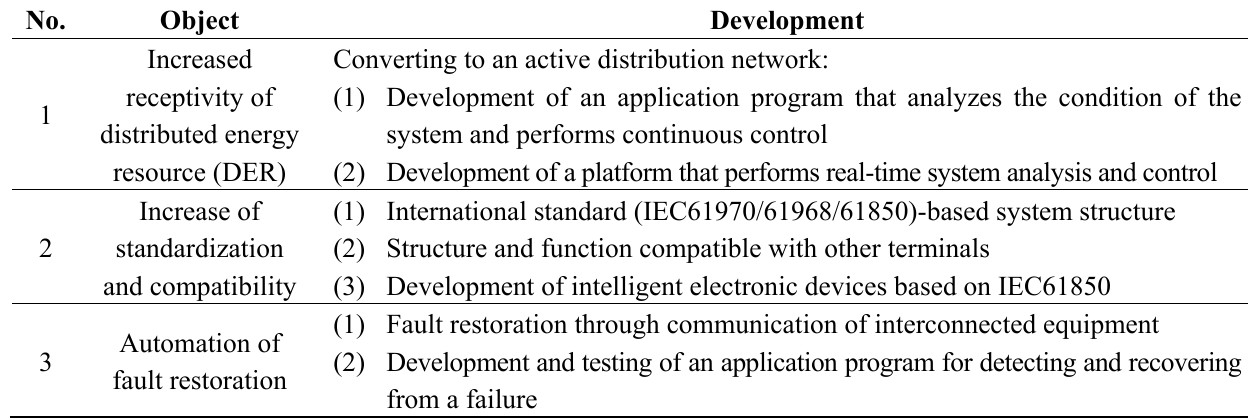
Table 2. Korean smart distribution management system (KSDMS)